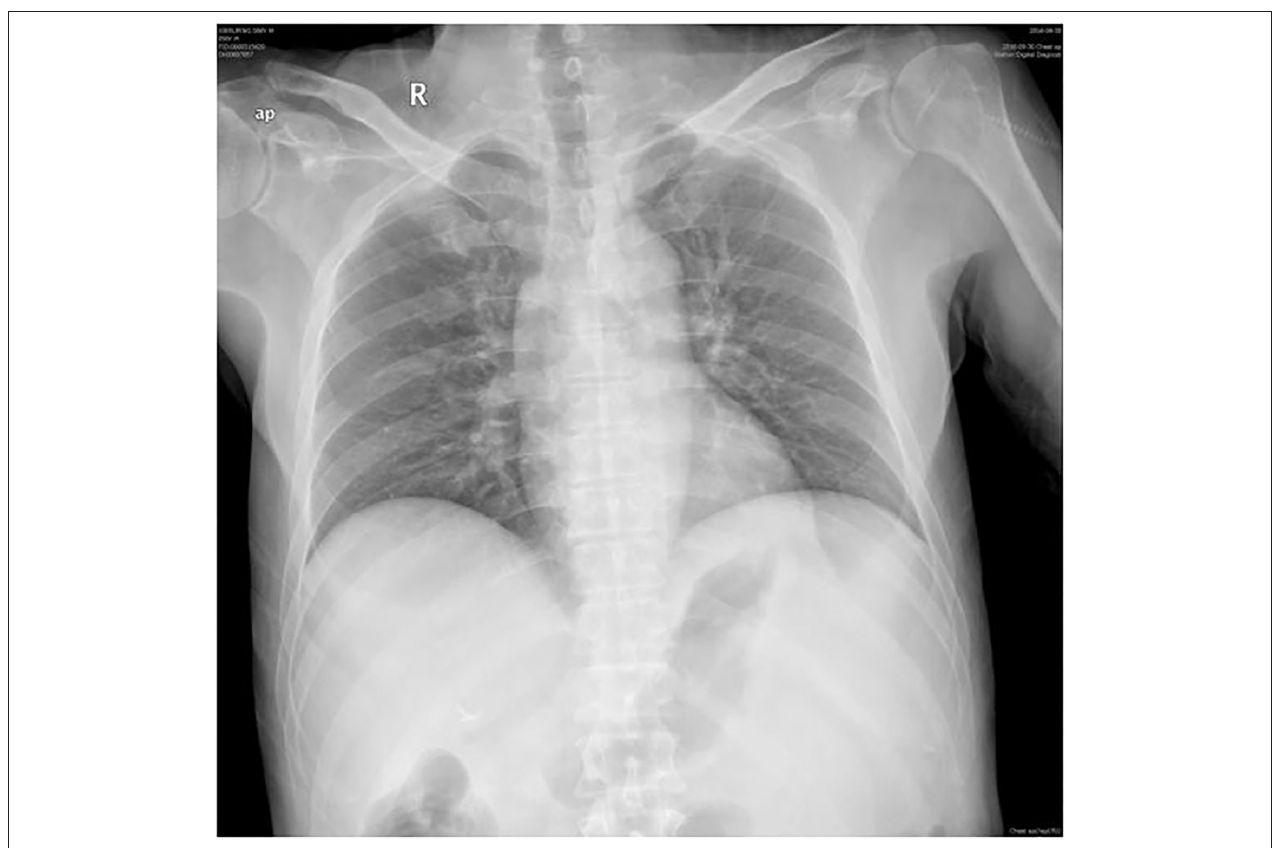
FIGURE 3 | Chest radiography. The cardio-thoracic proportion of 0.47, elevating dexter diaphragm.